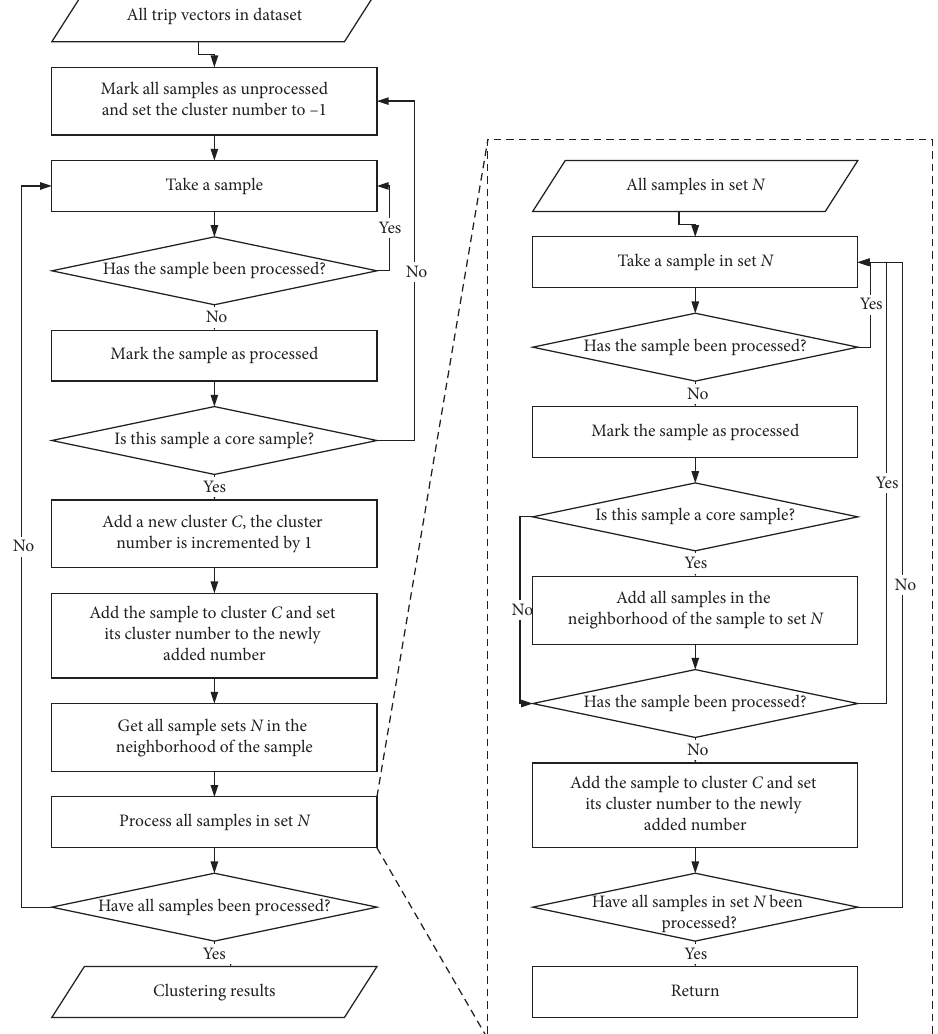
Figure 4: DBSCAN algorithm